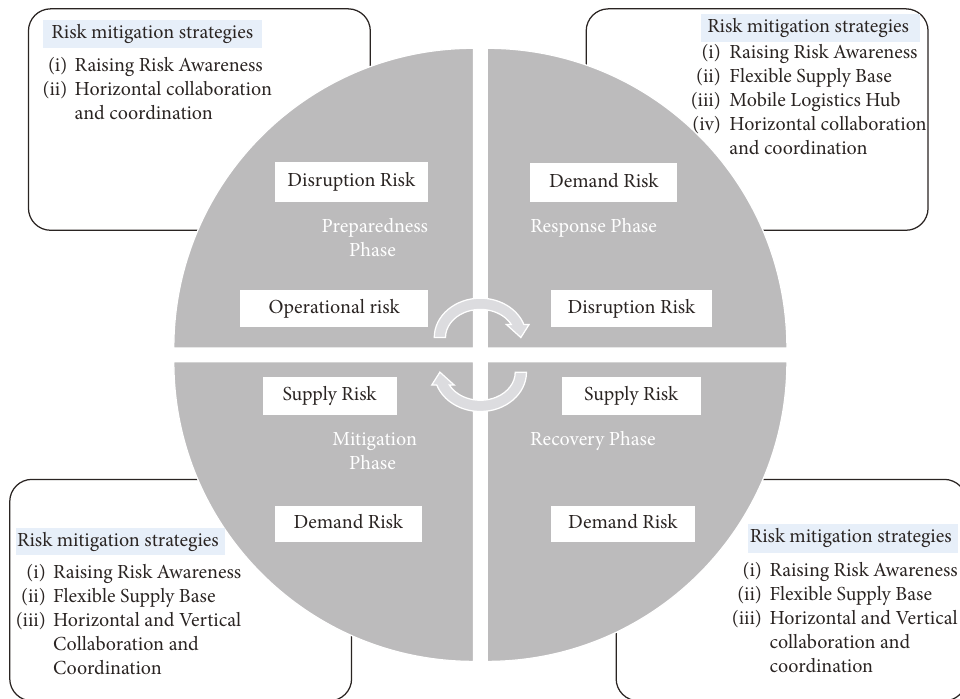
Figure 5: A conceptual framework identifying the dominant risks and supply chain risk mitigating strategies in the DMC